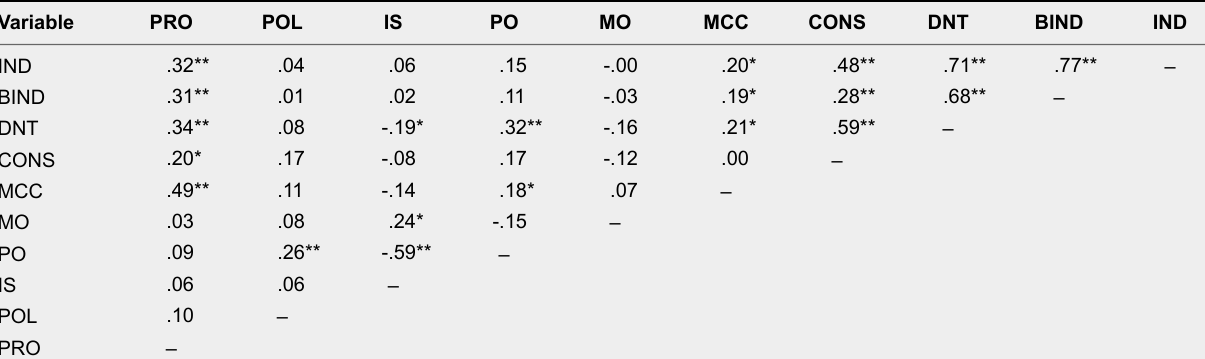
Pearson’s Correlations Between Continuous Variables in Study 3